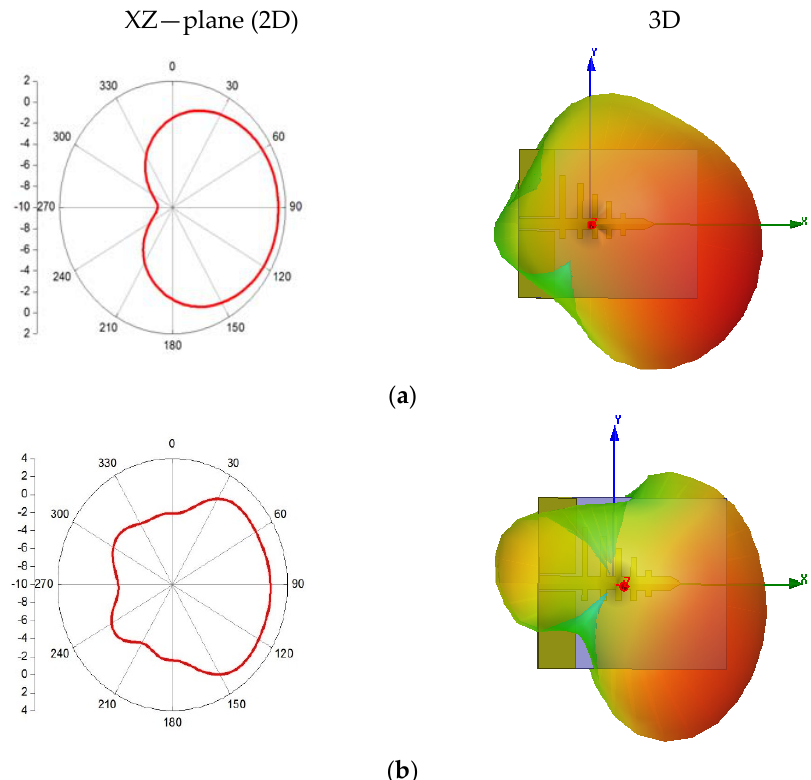
Figure 7. 2D and 3D radiation patterns of the PLPA at ( a ) 3.5 GHz and ( b ) 5 GHz.